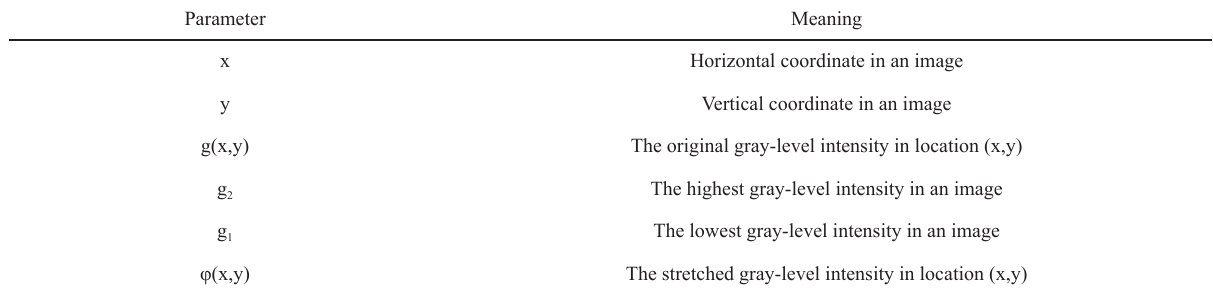
Table 2. Parameters in histogram